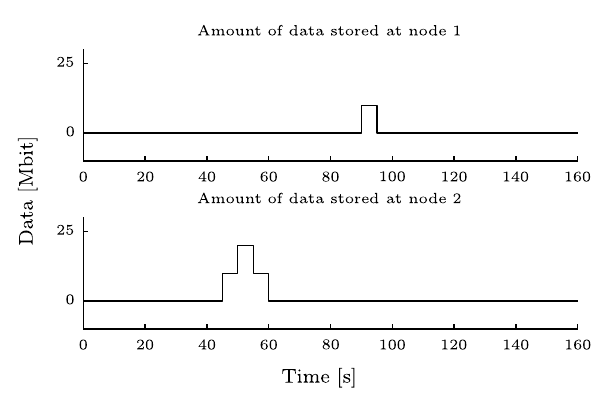
Figure 17: Scenario 2: The amount of data stored at the nodes at the 3rd and final